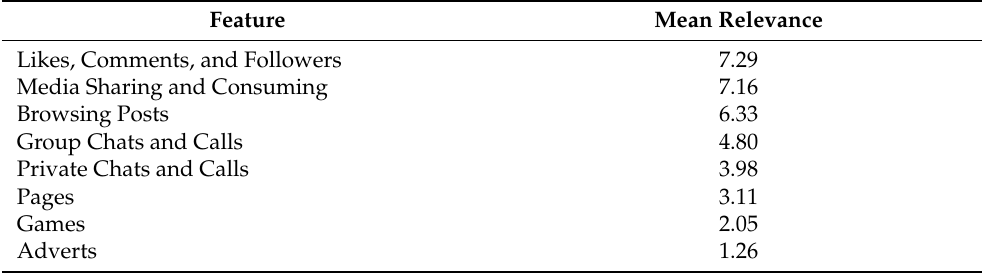
Table 2. Ranking the relevance of social media features to